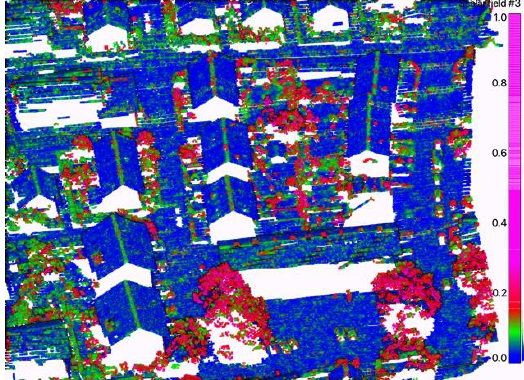
Figure 6. Computed local planarity feature shown for a part of the Vaihingen’s training data. Unit of the legend is meters. 3.2.3